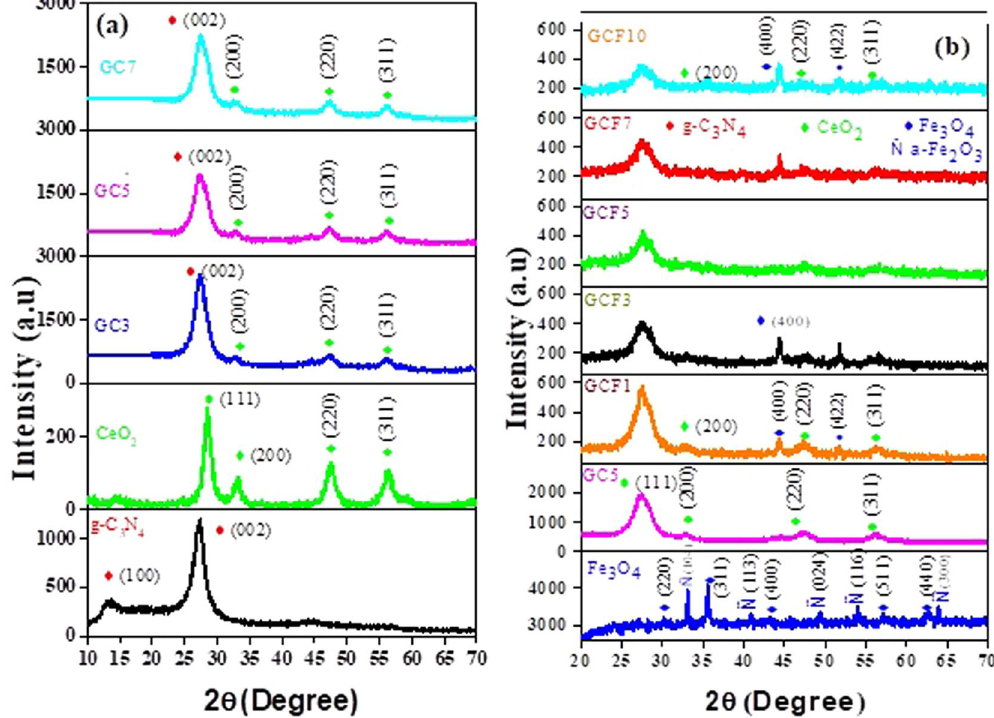
Figure 2. XRD patterns of (a) pristine g-C 3 N 4 , CeO 2 and g-C 3 N 4 /CeO 2 composites and (b) pristine Fe 3 O 4 , g-C 3 N 4 /CeO 2 (5%) and ternary